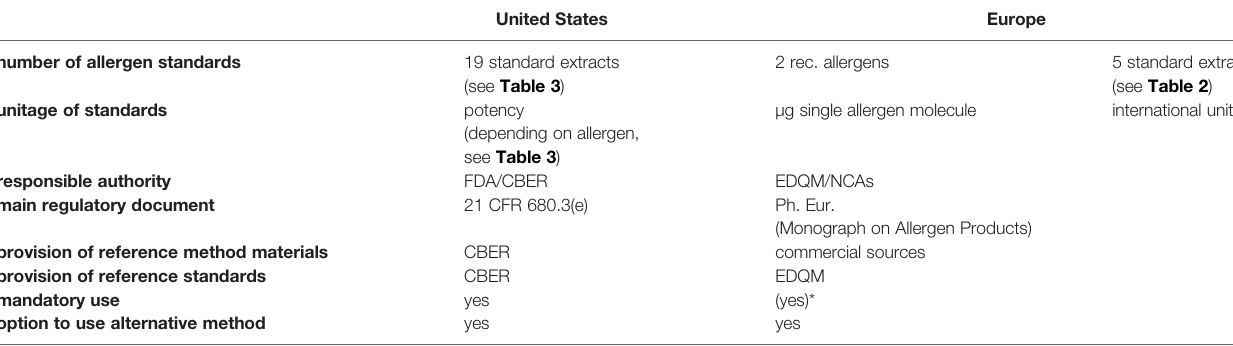
TABLE 5 | Comparison of reference standards and methods in the United States and